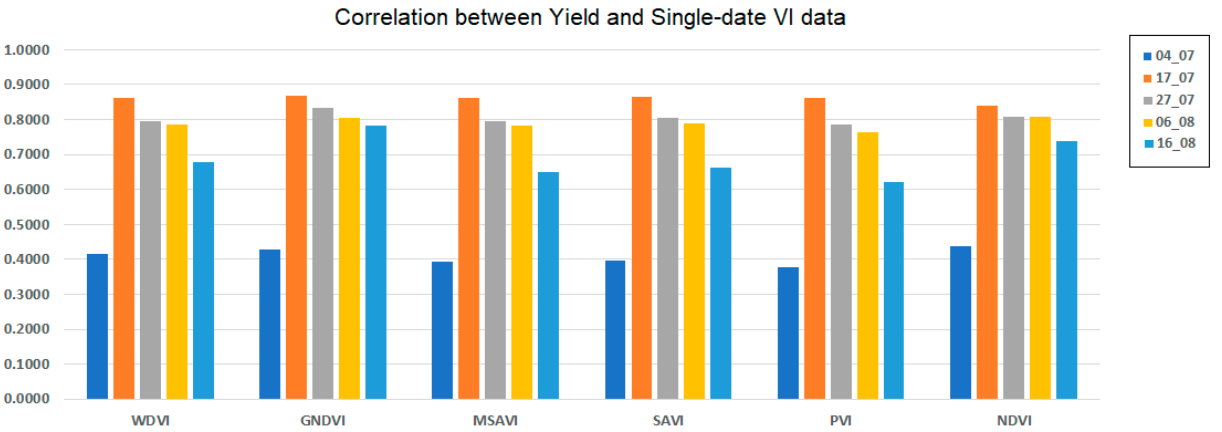
Figure 5. The correlation between single-date mean VI data and recorded yield, for all implemented VIs across all fields. Table 16. The regression models that best describe yield (expressed in t/ha) through VI data for the selected date (17_07) along with their adjusted R-Squared and MAE values (All VIs presented significant correlations at the p < 0.05 level).